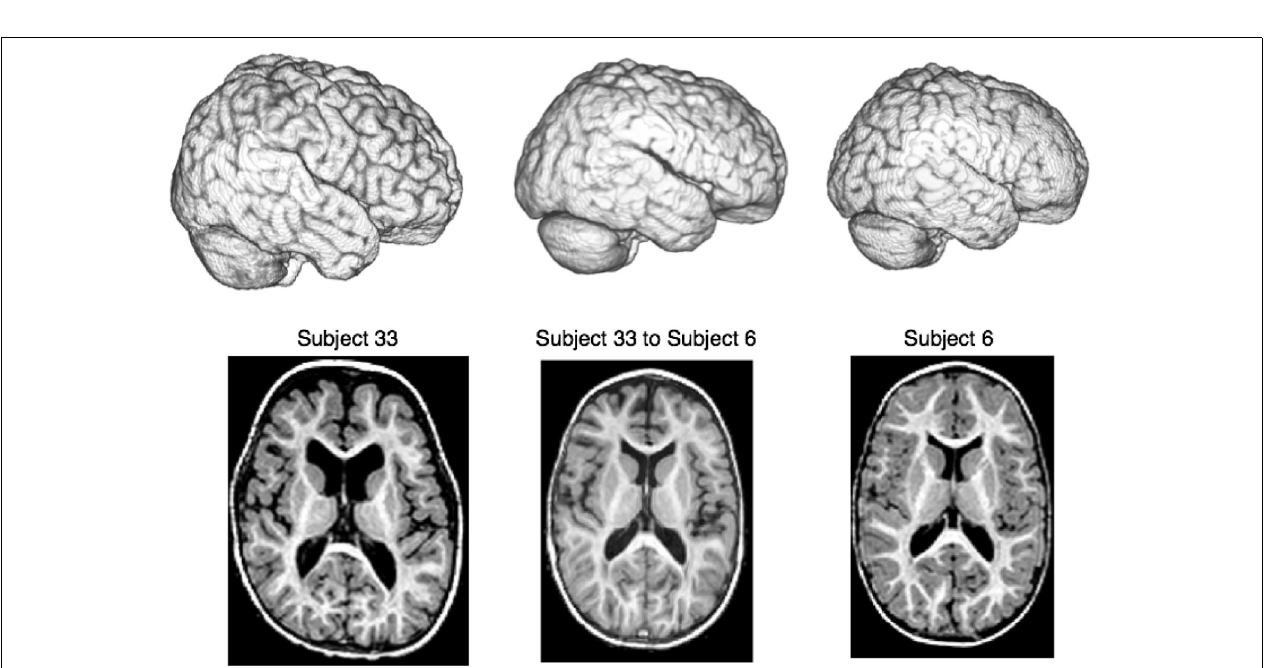
affine and deformable case. Thus, two parameters had to be optimized. We then applied these same parameters to register I and K via both correlation and mutual information. The resulting registrations (bottom row) were all of similar quality. Further, the same metric is used for both affine and diffeomorphic mapping by exploiting the general optimization process given in Equation (1).